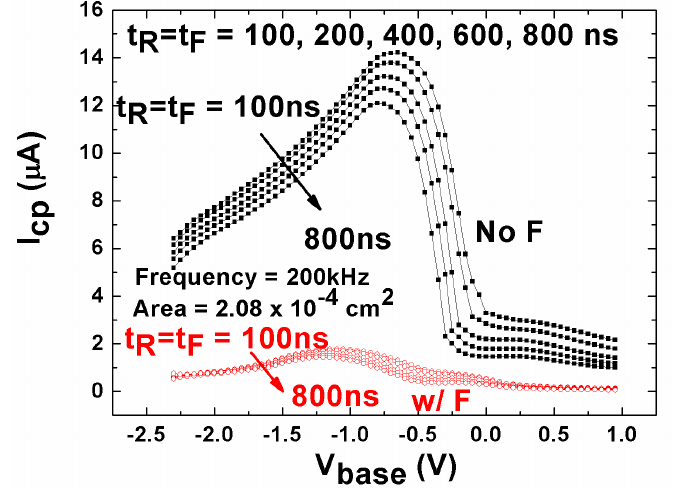
Figure 11. Charge pumping measurement with rise/fall time dependence. Samples with F incorporation show much smaller I amplitude is 1 V.